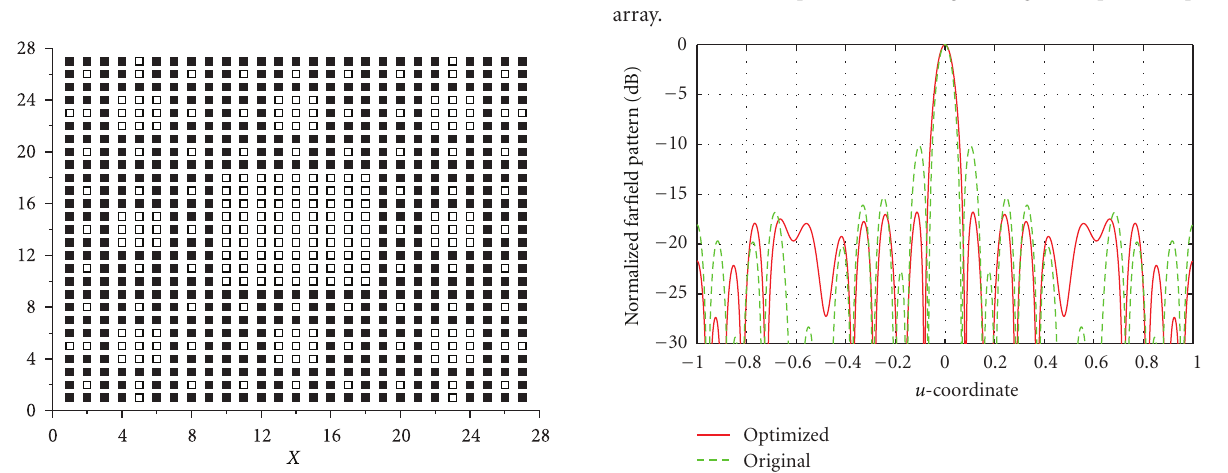
Figure 6: Optimized array structure for the first eaxmple.